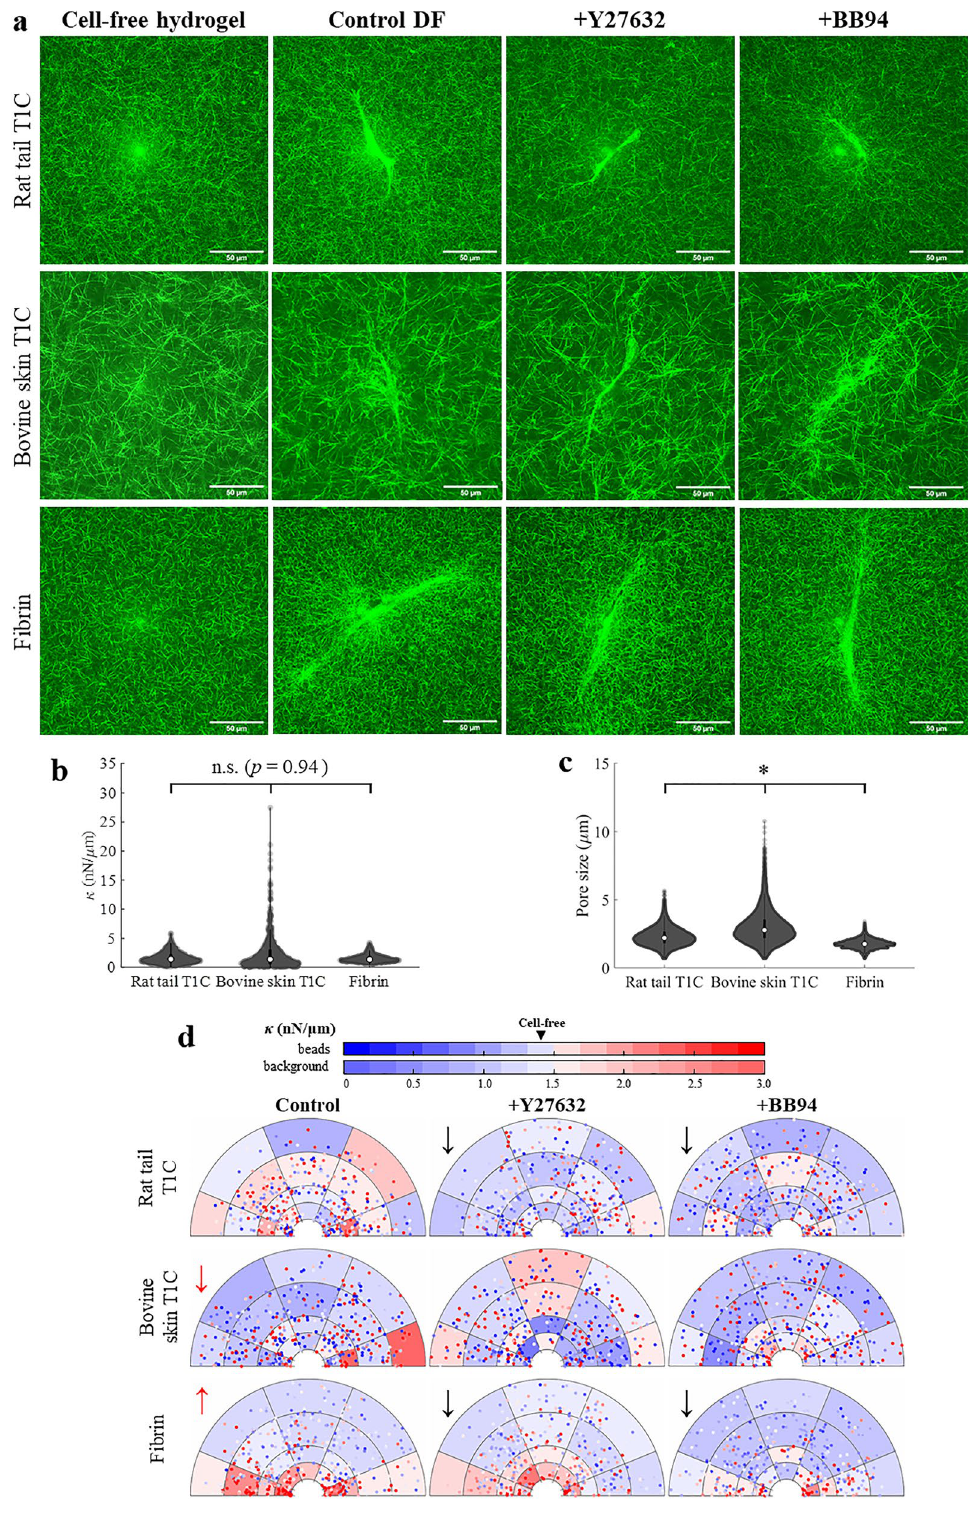
Figure 2. The effect of ECM type and treatment on stiffness distribution around DFs. ( a ) RCM images of cell-free hydrogels (rat tail T1C, bovine skin T1C, fibrin; n sample = 3 per ECM type, n beads > 40 per sample) and hydrogels containing DFs either untreated or treated with Y27632 and BB94 ( n sample = 5, n cells = 10 per condition, n beads > 40 per cell). ( b ) Stiffness κ and ( c ) pore size distribution of cell-free hydrogels. Median values are denoted by white markers. ( d ) κ distribution around DFs, probed along long axis of the cell. Background color is shaded according to the median κ value in each bin (background color bar). Each data point is a single probed bead, color-coded for κ (beads color bar). Arrows indicate significant difference ( p < 0.05) in κ . Control (untreated) conditions are compared to rat tail T1C hydrogels (red arrows), while treatment conditions are compared to the matched control condition (black arrows). Arrow direction indicates increased or decreased stiffness. * p <